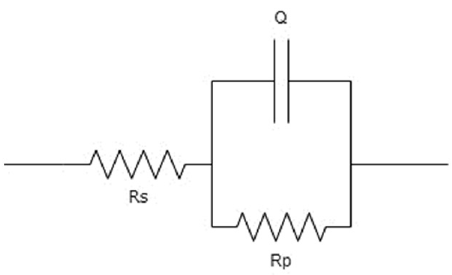
Figure 4. Equivalent circuit model: Randle’s circuit.